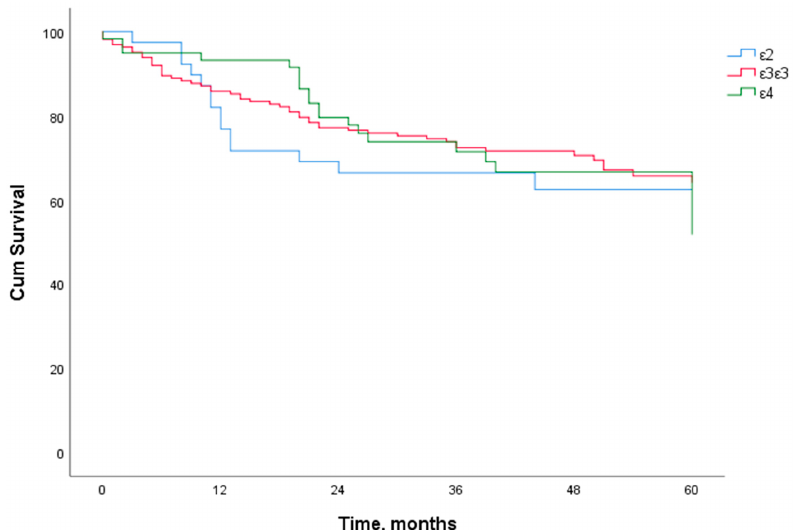
Figure 3. Five-year specific disease survival analysis of LSCC patients according to ApoE genotype and alleles ( ε 2, ε 3 ε 3, and ε 4). and alleles ( ε 2, ε 3 ε 3, and ε